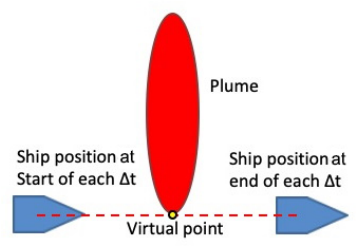
Figure 2. Virtual point for plume release in each time step ( (cid:49)t